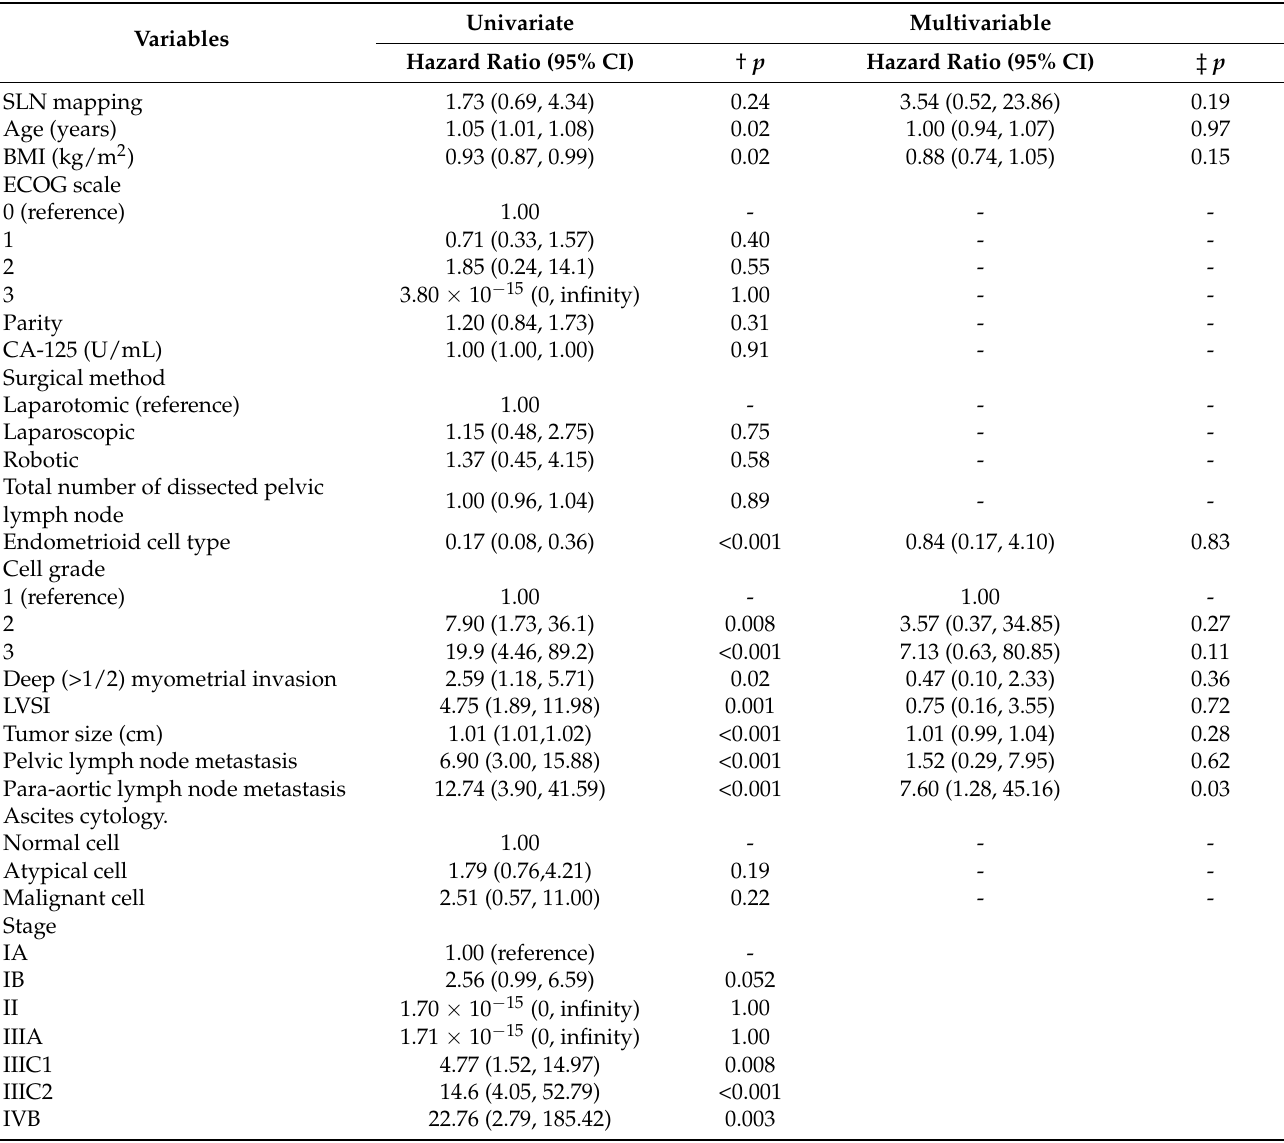
Table 3. Predictors for recurrence-free survival in women with clinically uterine confined endometrial cancer ( n =